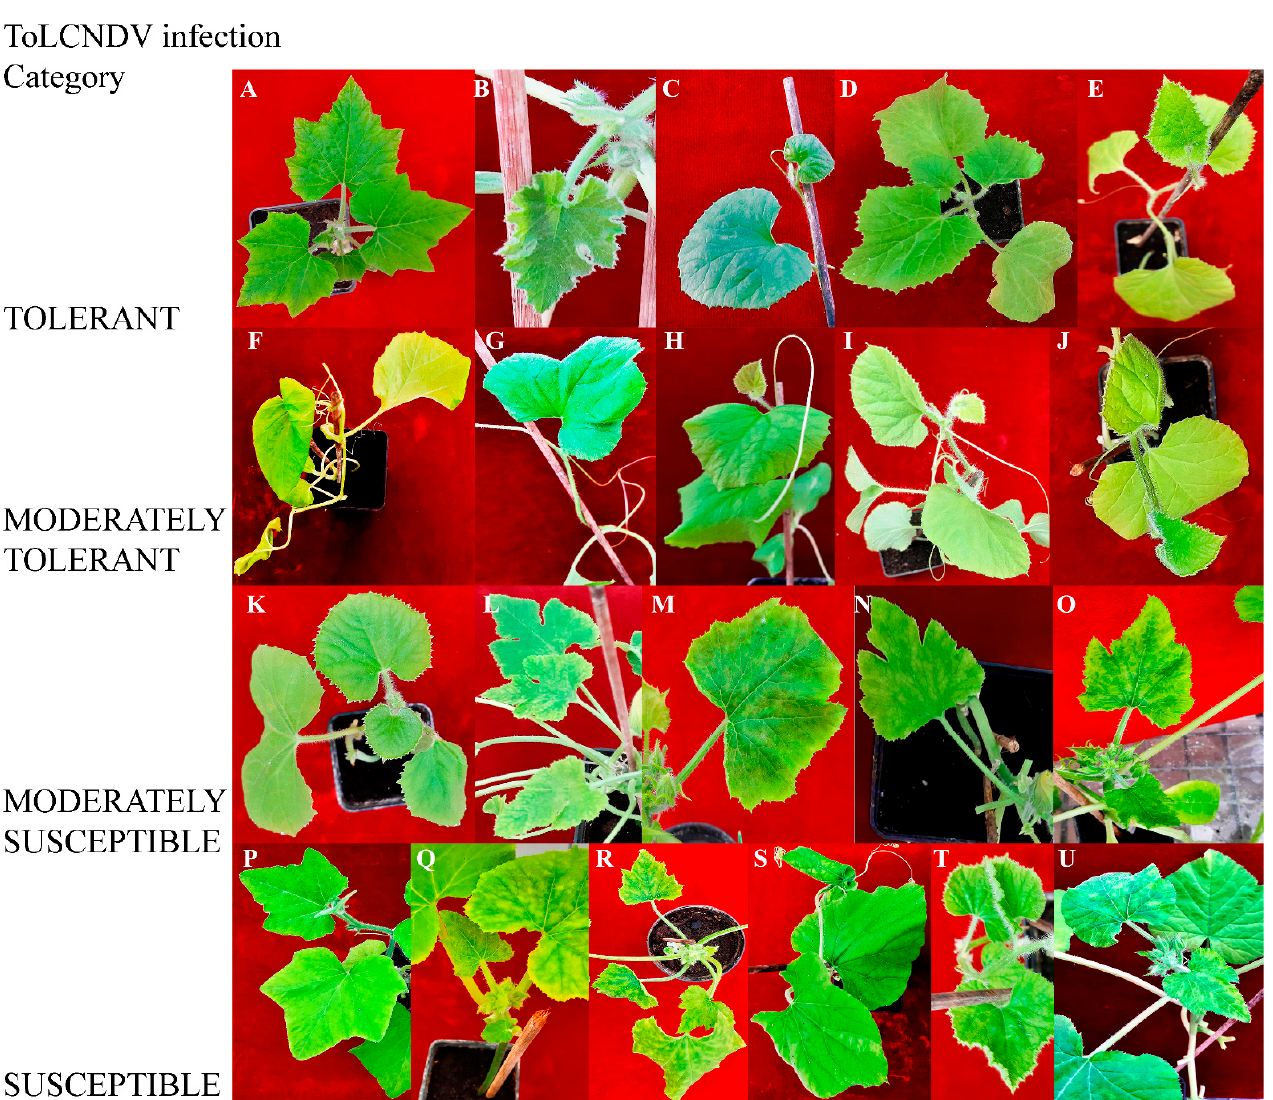
Figure 1. Systemic symptoms induced by ToLCNDV-Le at 28 dpi in different cucurbit species and cultivars classified as tolerant, moderately tolerant, moderately susceptible, and susceptible on the basis of disease symptoms developed: C. maxima cv. Invernale rigata ( A ); C. pepo accession 5 ( B ); C. melo cv. Tendral verde ( C ); C. melo cv. Barattiere ( D ); C. melo ecotype Invernale variopinto ( E ); C. melo ecotype Invernale giallo ( F ); C. melo ecotype Verde tondo ( G ); C. melo ecotype Invernale a fasce ( H ); C. melo ecotype Invernale bianco ( I ); C. melo cv. Rugoso di Cosenza ( J ); C. melo cv. Retato standard (no F1 hybrid) ( K ); C. pepo cv. President ( L ); C. melo ecotype Retato (Cantalupo) ( M ); C. pepo accession 63 ( N ); C. moschata cv. Moscata di Provenza ( O ); C. moschata cv. Cucuzza Genovese ( P ); C. pepo cv. Howden ( Q ); C. pepo cv. Scuro di Milano ( R ); L. siceraria spp. ( S ); C. melo cv. Retato standard (F1 hybrid) ( T ); C. pepo cv. Corritore ( U ).